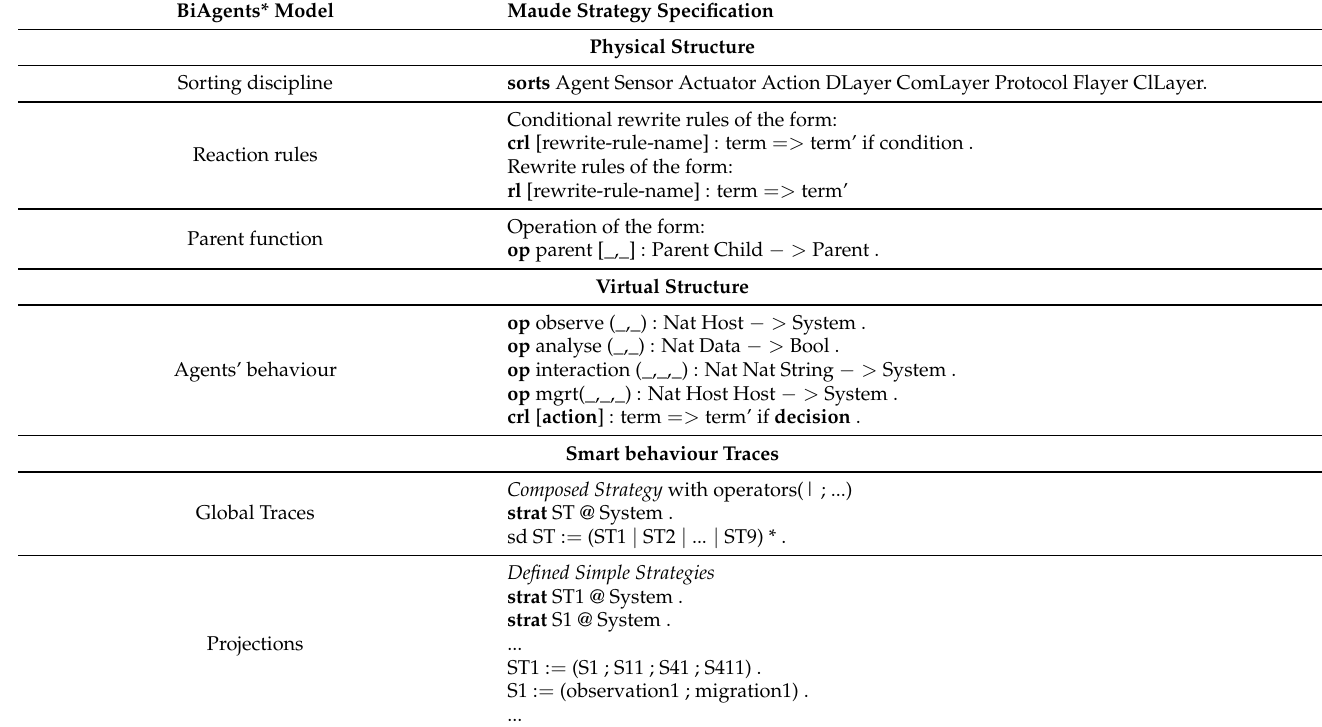
Table 8. From BiAgents* to Maude